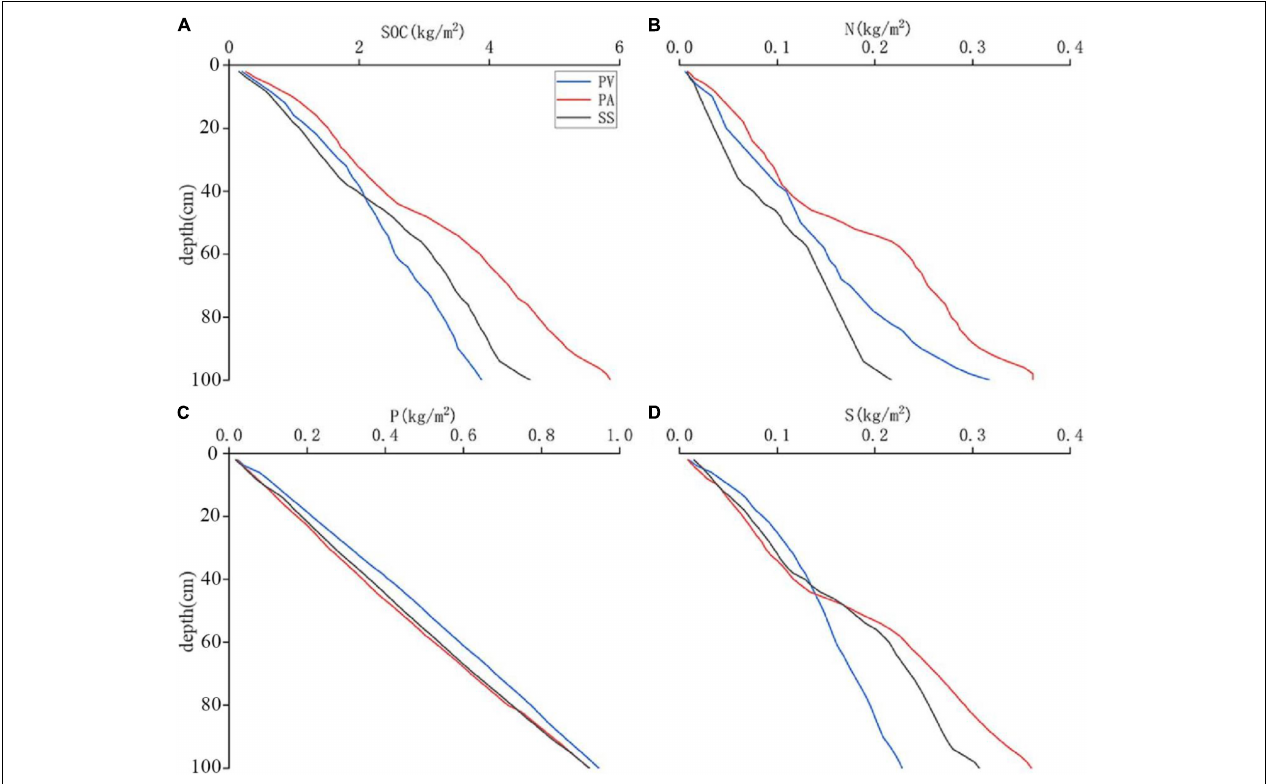
FIGURE 3 | Accumulative distributions of the stocks of C (A) , N (B) , P (C) , and S (D) along with different soil profiles in PV, PA, and SS